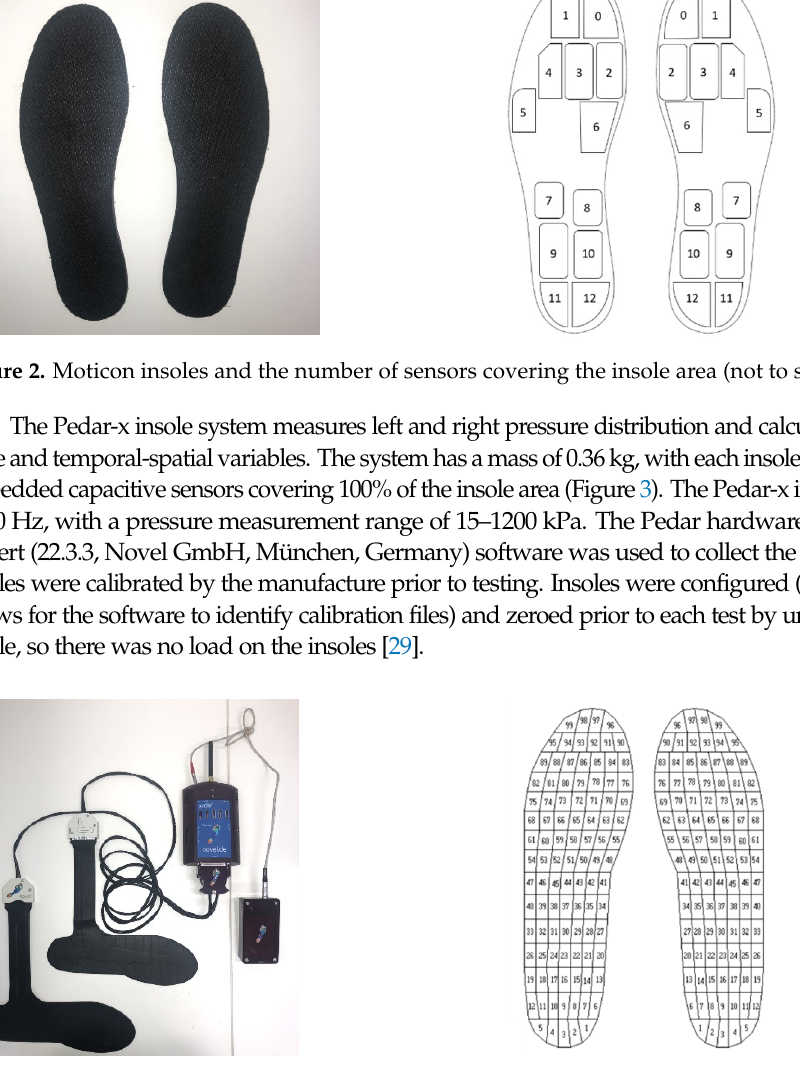
Figure 3. Pedar-x insole system set-up and the number of sensors covering the insole area. A footplate (ErgAdaptor, BAT Logic, Victoria, Australia) with rowing shoes (New Wave, Oberaudorf, Germany) was installed onto the Concept2 ergometer foot-stretcher (Figure 4). The foot cradle on the Concept2 was removed and the ErgAdaptor footplate was adapted to allow it to be screwed in place of the Concept2 foot-cradle.